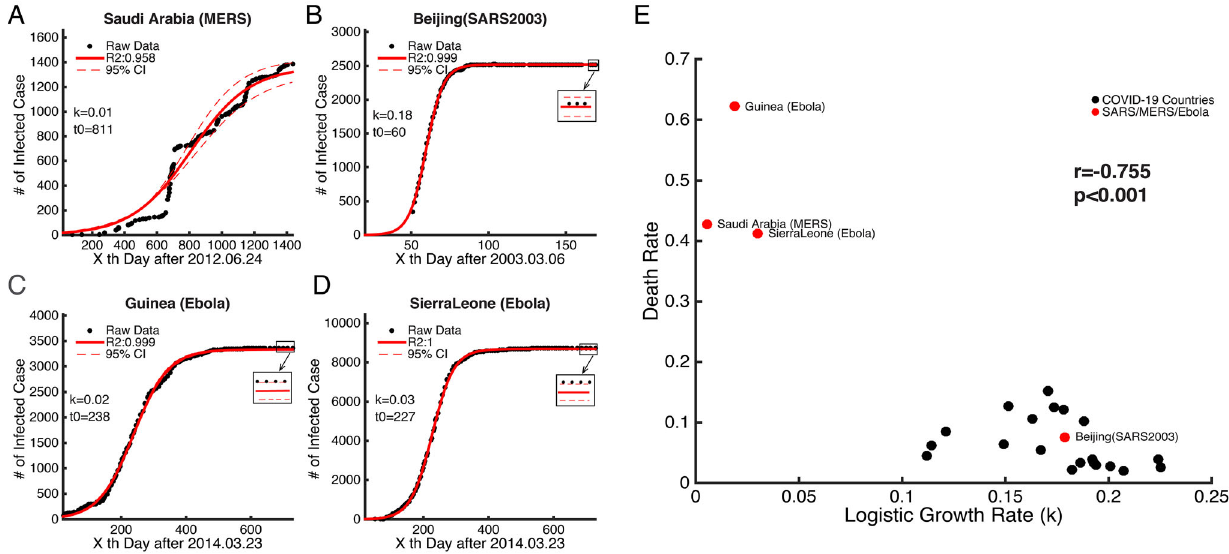
Fig. 11 Example of the time series of cases infected with MERS, SARS, and Ebola, and the relationship between the death rate and the logistic growth rate ( k